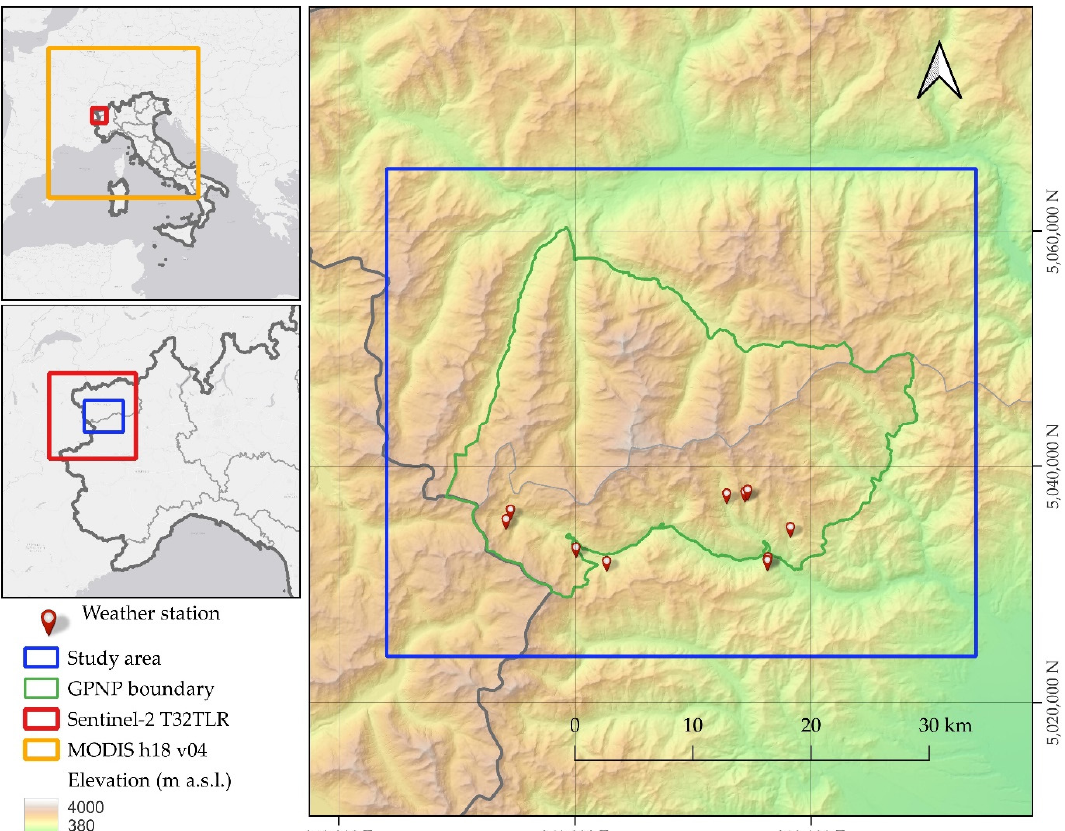
Figure 1. Study area (blue line), located in NW Alps, Italy, and centered on the Gran Paradiso National Park (GPNP, green line). The study area is entirely covered by the Sentinel-2 tile T32TLR (red line).